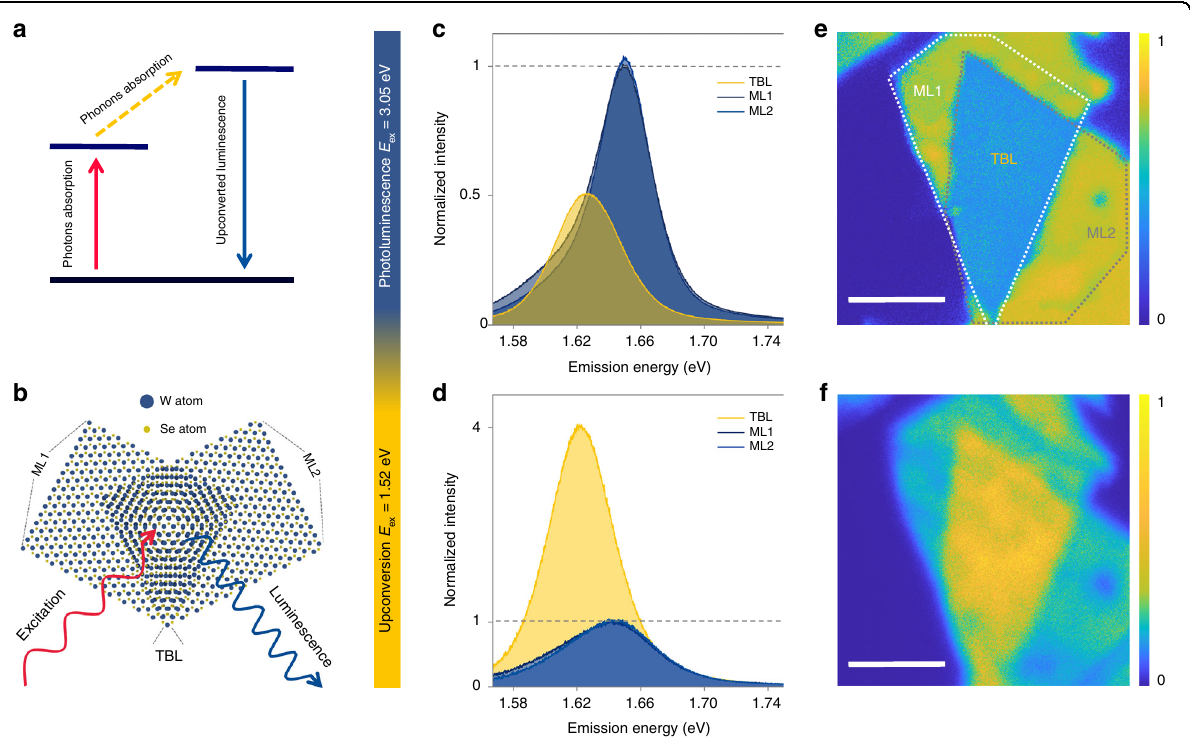
Fig. 1 Phonon-assisted upconversion enhancement in a 5.5° twisted bilayer WSe 2 . a Schematic of phonon-assisted upconversion mechanism. b Schematic of the device structure. c , d PL ( c ) and UPC ( d ) spectra of ML1(dark blue lines), ML2 (blue lines) and TBL (yellow lines), gray dotted lines indicate intensities normalized as 1. e , f PL ( e ) and UPC ( f ) maps of the corresponding bilayer sample in c and d , scale bar 5 μ